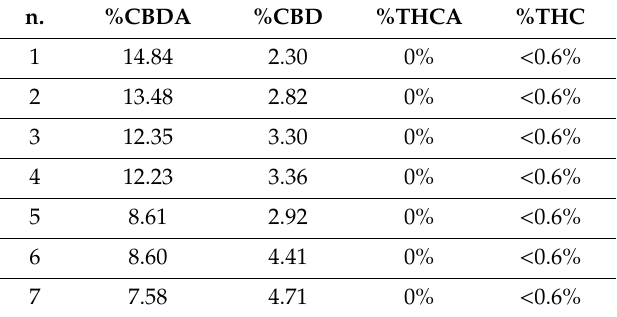
Table 3. Percentage of cannabinoids contained in the various hemp extracts.